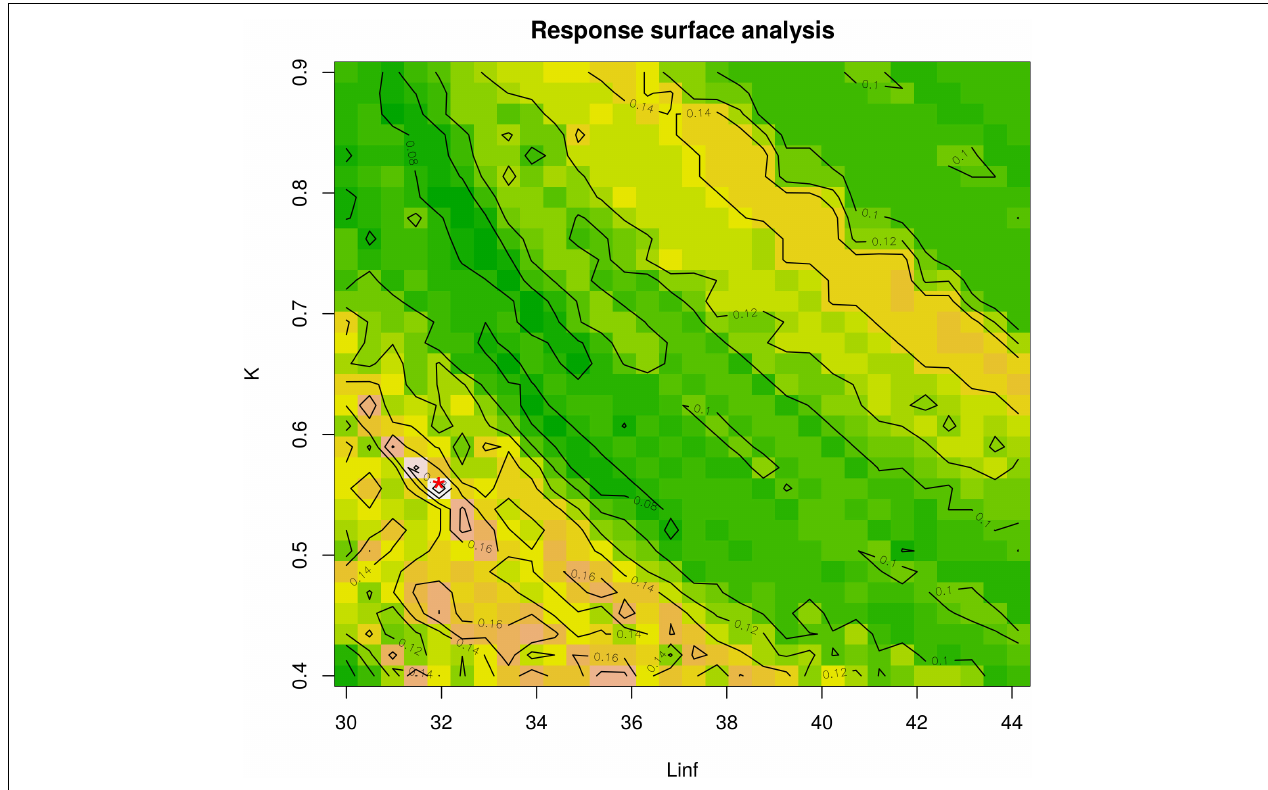
FIGURE 4 | Response surface analysis. The best fit for the combination between Linf (in mm) and K -values is indicated with a red asterisk on the plot. The color scale corresponds to the Rn values from ELEFAN analysis. K ranges between 0.4 and 0.9 and L inf ranges between 30 mm (maximum observed length) and 44.13 mm (estimated by Froese and Binohlan). This analysis corresponds to the optimal combination from Table 1 .